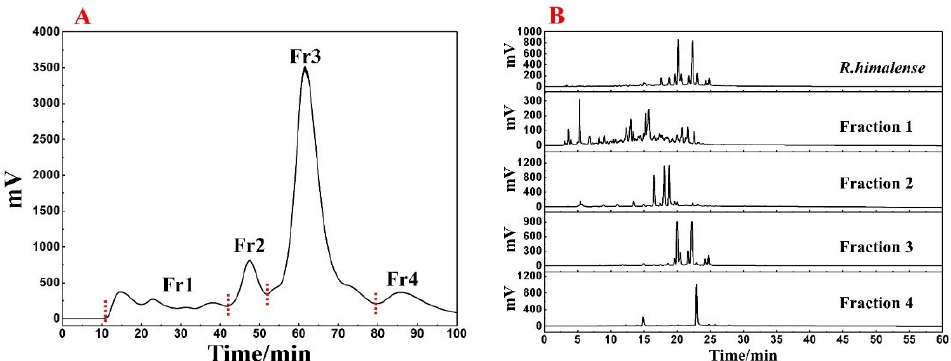
Figure 1. ( A ) polyamide-MPLC separation chromatogram of R. himalense extract-polyamide mixture. ( B ) Comparative chromatogram of the crude sample and each fraction after pretreatment.